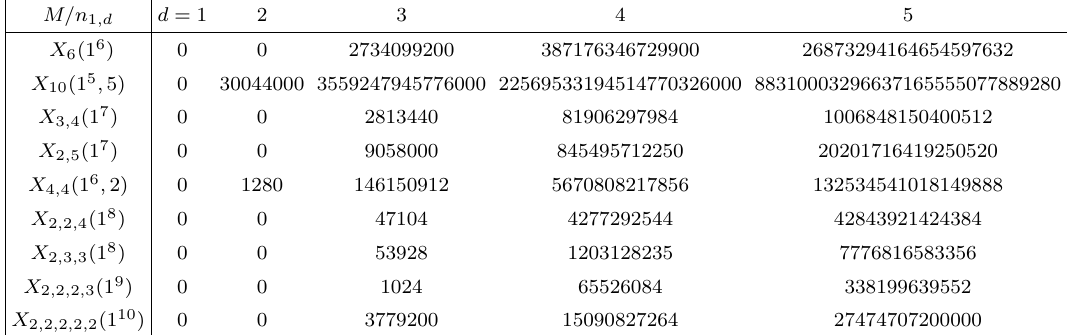
Table 2 . Genus 1 invariants for several one parameter CY fourfold